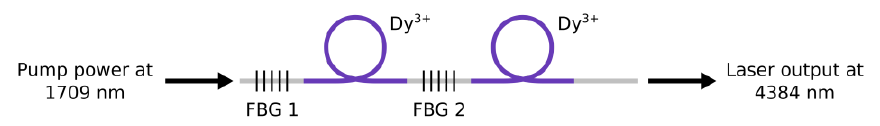
Figure 8. Set-up of the master oscillator power amplifier (MOPA) fiber laser proposed in [34]. Figure adapted from [34].